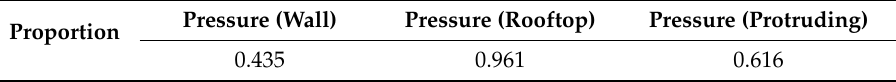
Table 10. Correlation between proportion and oppressive feelings.